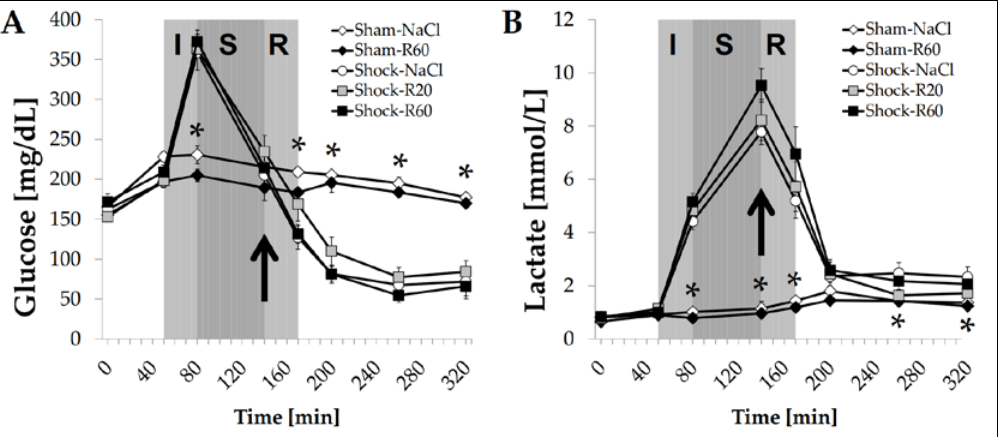
Figure 8. Effect of continuous intravenous infusions of solvent-free low-dose resveratrol on blood glucose and lactate concentrations subsequent to severe hemorrhagic shock in rats. Rats underwent severe hemorrhage (30 min shock induction, I; 60 min shock phase, S), then were resuscitated (R, within 30 min) with the withdrawn blood and LR equal to twice the volume of the withdrawn blood (30 min) in the absence (Shock-NaCl) or presence of resveratrol (20 or 60 µ g/kg × h until the end of the experiment; Shock-R20, Shock-R60) and observed for a further 150 min. Sham animals received either pure 0.9% NaCl solution (Sham-NaCl) or the higher resveratrol dose (Sham-R60). Blood glucose ( A ) and lactate ( B ) concentrations were determined in plasma from arterial blood samples as obtained at the time points indicated. Shown are mean values ± SEM ( n = 8 animals per group). * p < 0.05 (vs. Shock-NaCl). The arrow indicates the start of the resveratrol infusions.